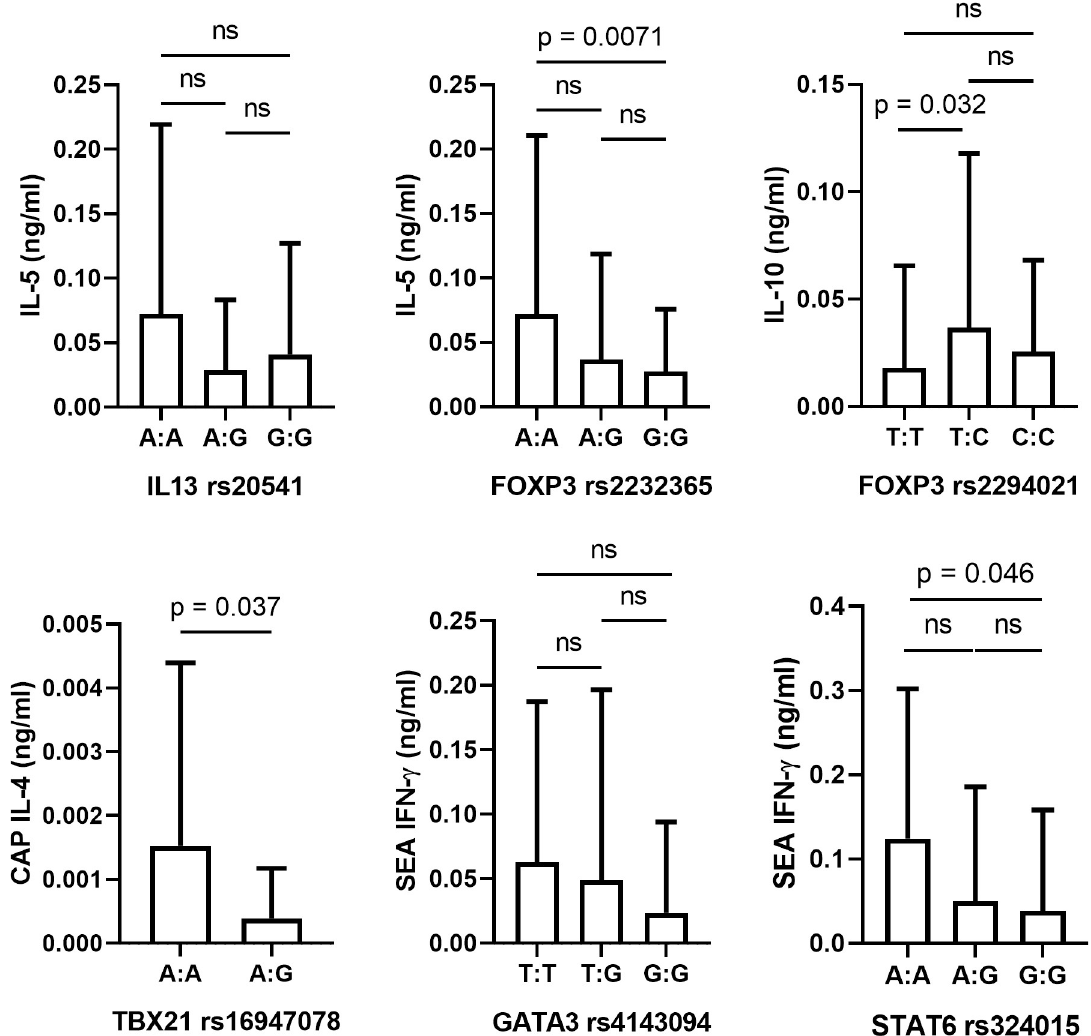
Fig 4. Mean cytokine concentrations between SNP genotypes. Analysis of variance identified relationships between systemic or parasite specific cytokine levels and six SNPs: IL13 rs20541 (systemic IL-5), FOXP3 rs2232365 (systemic IL-5), FOXP3 rs2294021 (systemic IL-10), TBX21 rs16947078 (CAP-specific IL-4), GATA3 rs4143094 (SEA-specific IFN γ ), and STAT6 rs324015 (SEA-specific IFN γ ). Pairwise p-values are Bonferroni corrected. Error bars indicate SD. CAP = cercariae antigen preparation; SEA = soluble egg